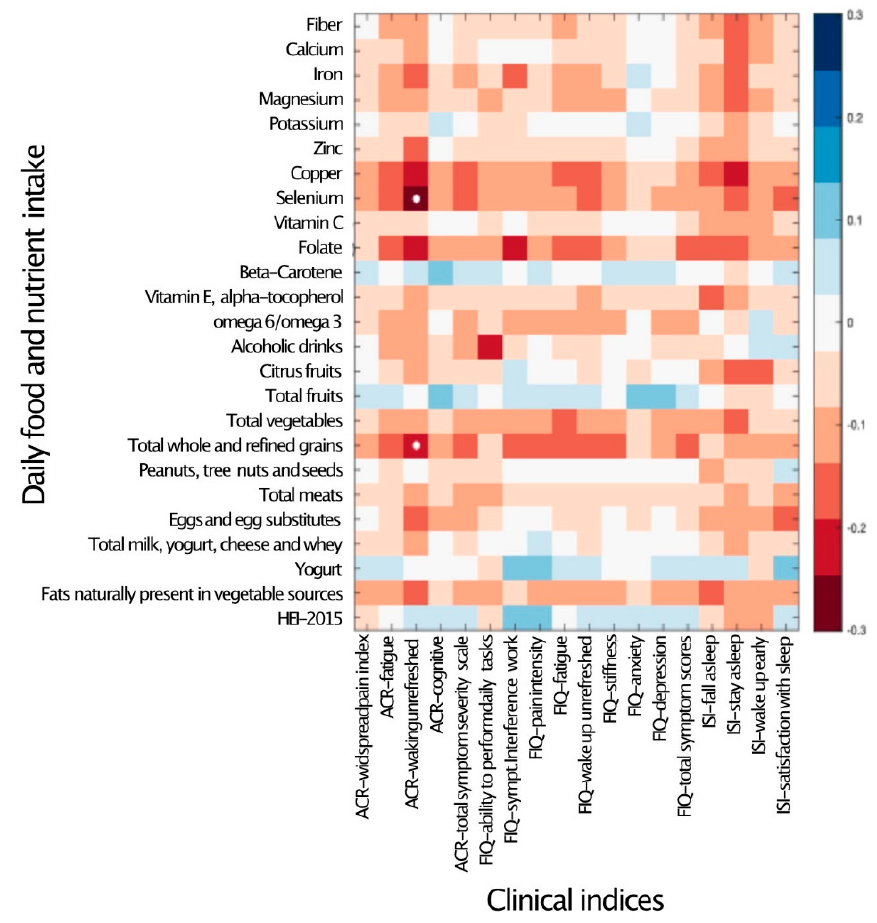
Figure 1. Daily nutrient and food intake is mostly not associated with clinical indices. Heat map of a univariate Kendall correlation matrix between the daily intake of fiber, selected micronutrients and food groups ( y -axis) vs. clinical covariates ( x -axis): disease severity metrics (FMDC: 2016 fibromyalgia diagnostic criteria); quality of life scores (FIQ); and sleep quality (sleep) scores. Blue shades indicate positive correlations while red shades indicate negative correlations ( − 0.5 < tau < 0.5). Statistically significant correlations are marked by a white circle (Benjamini–Hochberg FDR < 0.05). Food intake units are provided in Table 3. ACR–American College of Rheumatology Criteria; ISI–Insomnia Severity Index; and HEI 2015–Healthy Eating Index